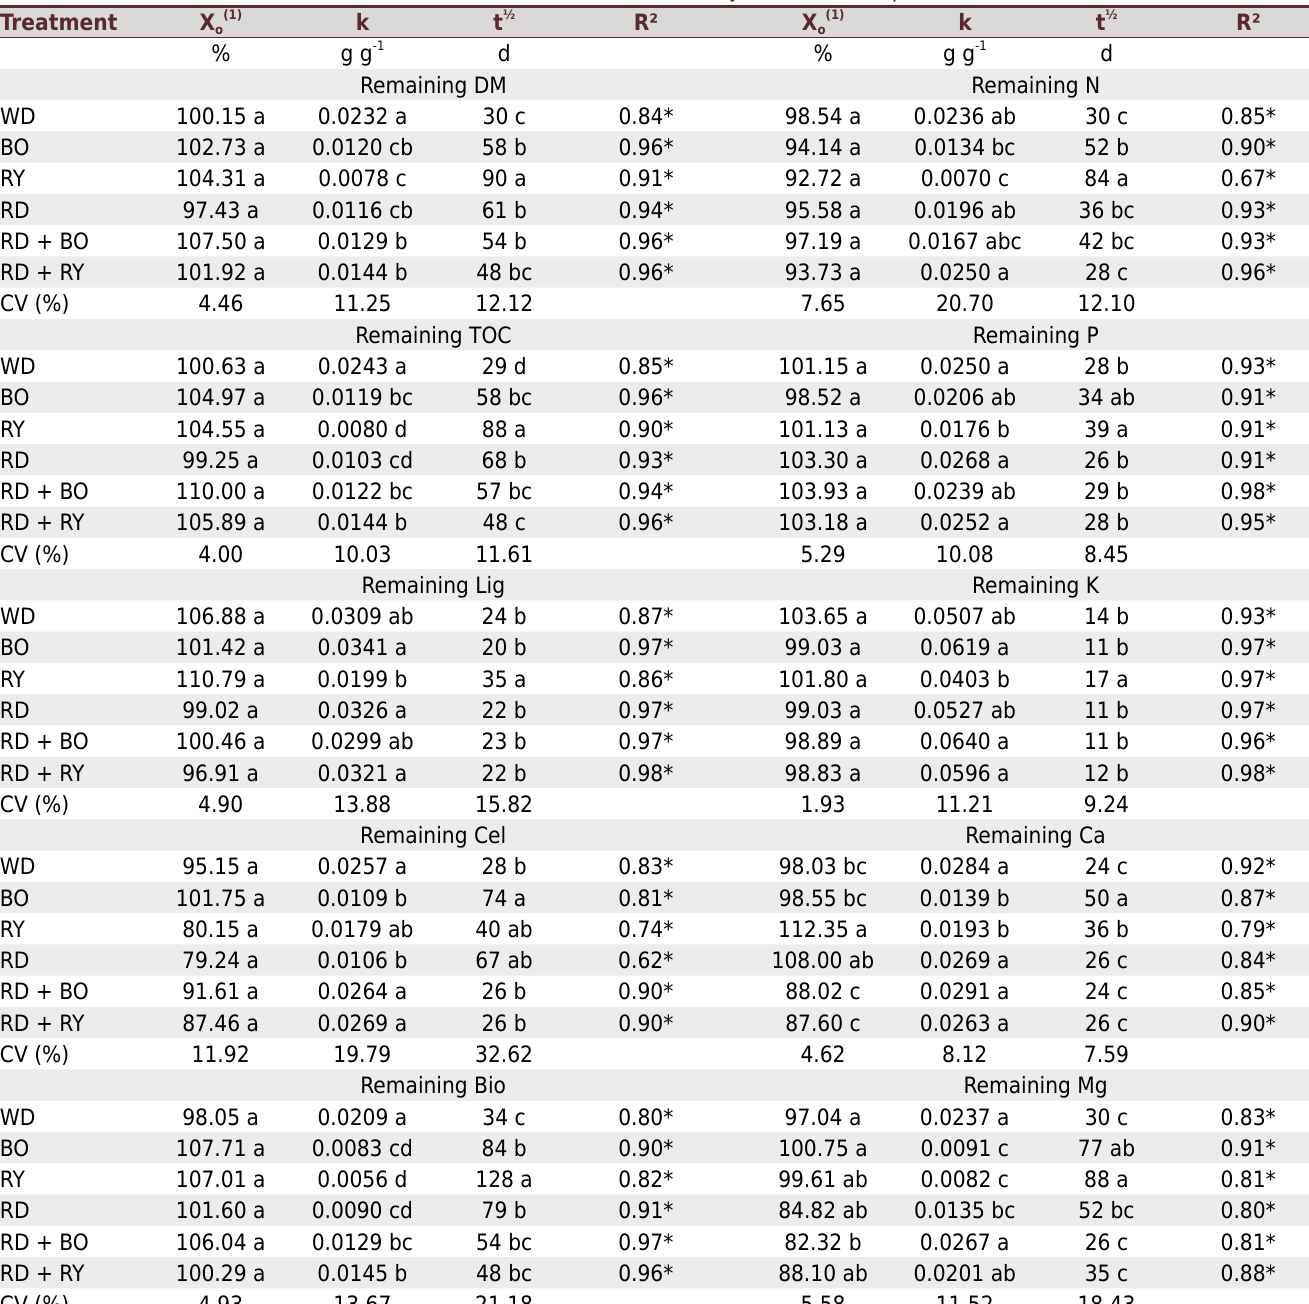
Table 2. Parameters fitted (X = X o e (-kt) ) to the values of remaining dry matter (DM), total organic carbon (TOC), lignin (Lig), cellulose (Cel), non-structural biomass (Bio), nitrogen (N), phosphorus (P), potassium (K), calcium (Ca) and magnesium (Mg); decomposition constant (k); and half-life (t ½ ) of each compartment and R 2 values for the residues of weeds (WD), black oat (BO), rye (RY), oilseed radish (RD), oilseed radish + black oat (RD + BO), and oilseed radish + rye (RD + RY) deposited on the onion